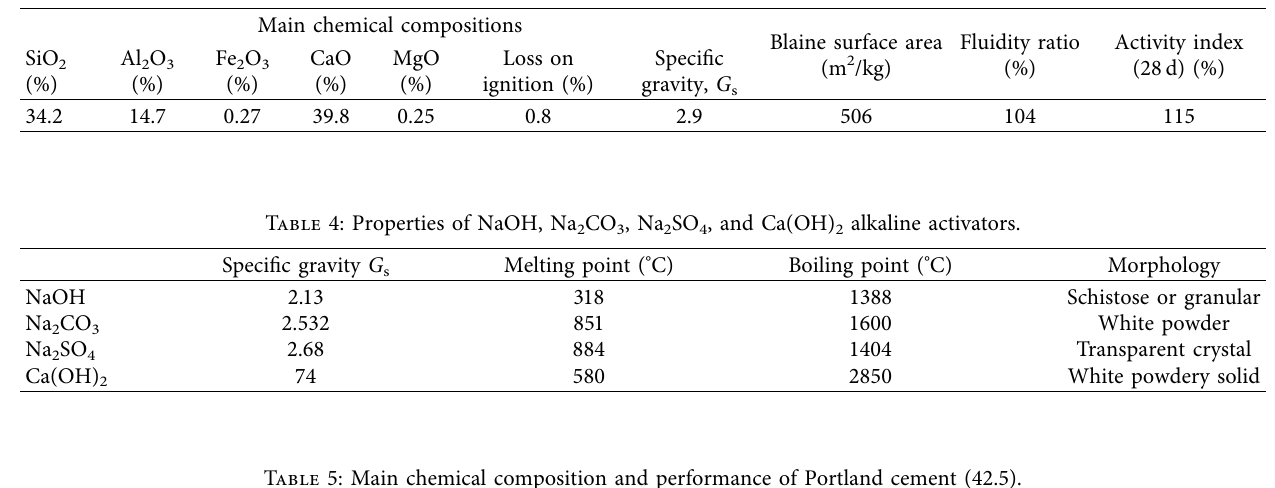
Table 3: Main chemical composition and performance of GGBS.